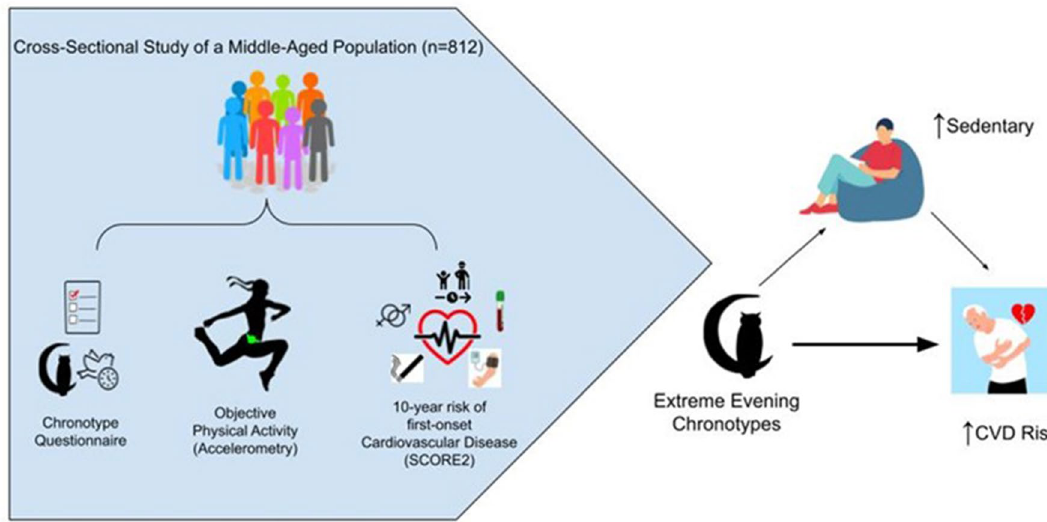
Figure 5. Study summary. Cross-sectional analysis of chronotype, physical activity by accelerometry, and 10-year risk of CVD was performed in a middle-aged cohort. Extreme evening chronotype was associated with increased 10-year risk of CVD compared to extreme morning types. This association was partially mediated by increased time spent sedentary among extreme evening